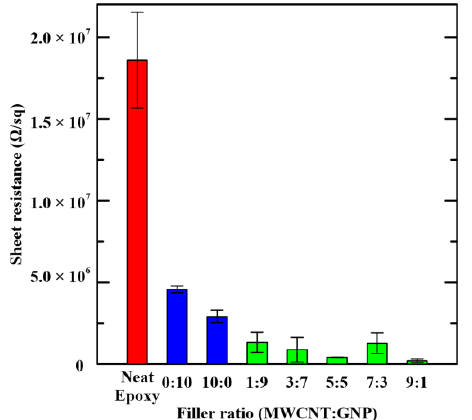
Figure 8. Variation of measured sheet resistances of the studied nanocomposites with the employed filler ratios in the specimen preparation.